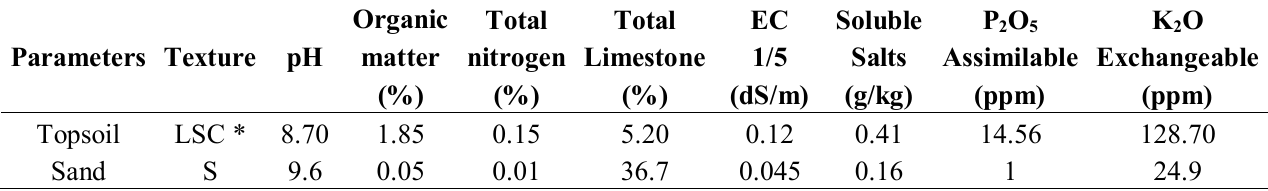
Table 1. Tests results of soil and